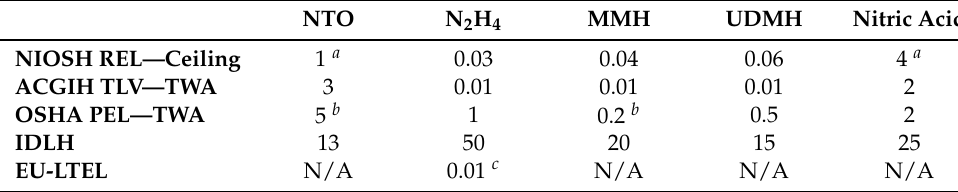
Table 1. Occupational exposure limits of typical storable propellants (ppm)